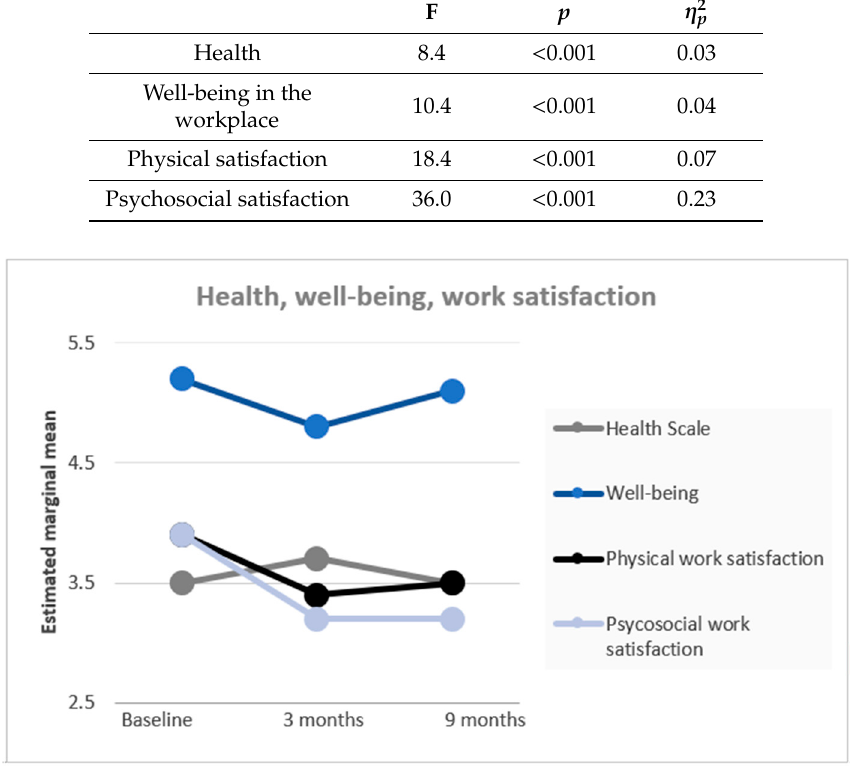
Table 2. Repeated measure ANOVA comparing health, well-being, and work satisfaction between baseline, 3 months, and 9 months after relocation ( n = 246). Tests of Within-Subjects E ff ects, Repeated Measure ANOVA F p η 2 p